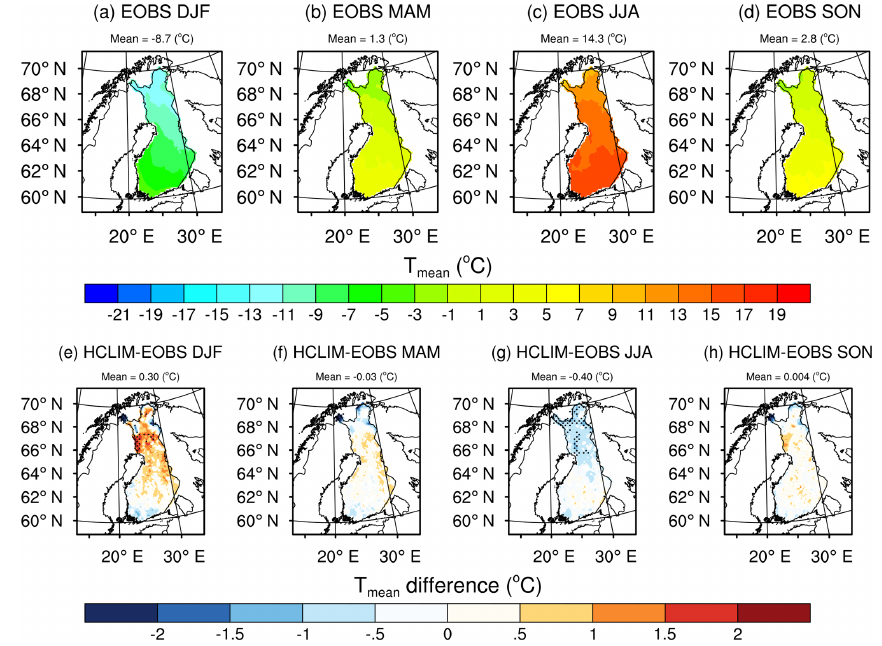
Figure 3. (a–d) The reference values of mean near-surface air temperatures ( T mean ) from E-OBS data and (e–h) the biases of HCLIM38- ALARO modeled T mean with a reference to E-OBS. The seasonal means were calculated over the whole model domain for the time period of January 2002–December 2014. Stippled areas represent statistically significant differences with p values < 0 . 05.